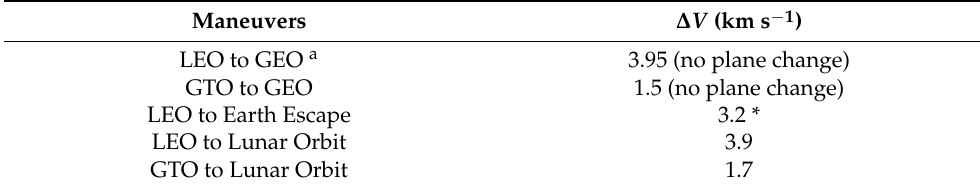
Table 2. Orbital changes ∆ V using impulsive shot maneuvers